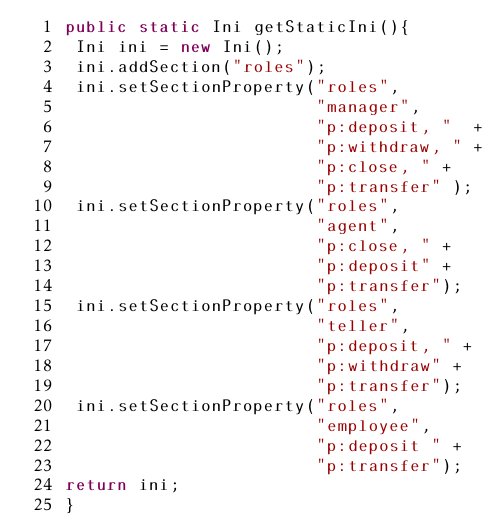
Manager is shownas a dottedline.